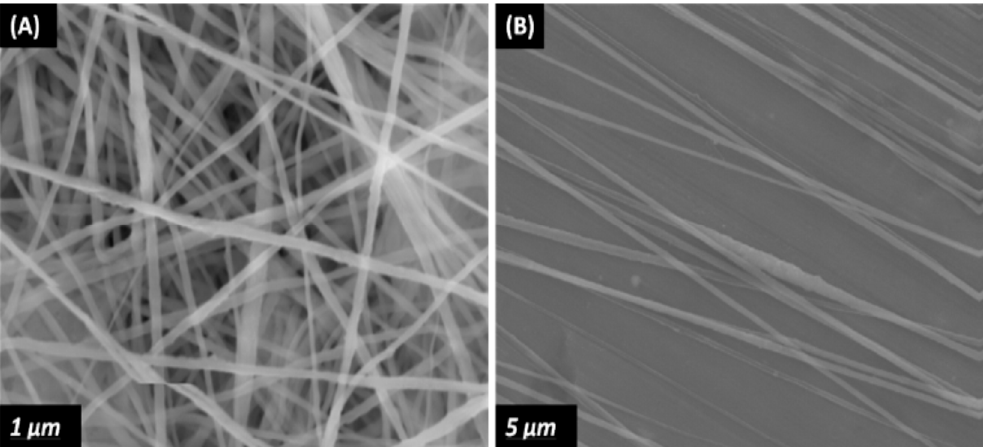
Figure 15. ( A ) Randomly oriented PVDF nanofibers deposited on a stationary metal plate covered with aluminum foil. ( B ) Aligned PVDF nanofibers deposited at the gap between two metallic bars of a collector.